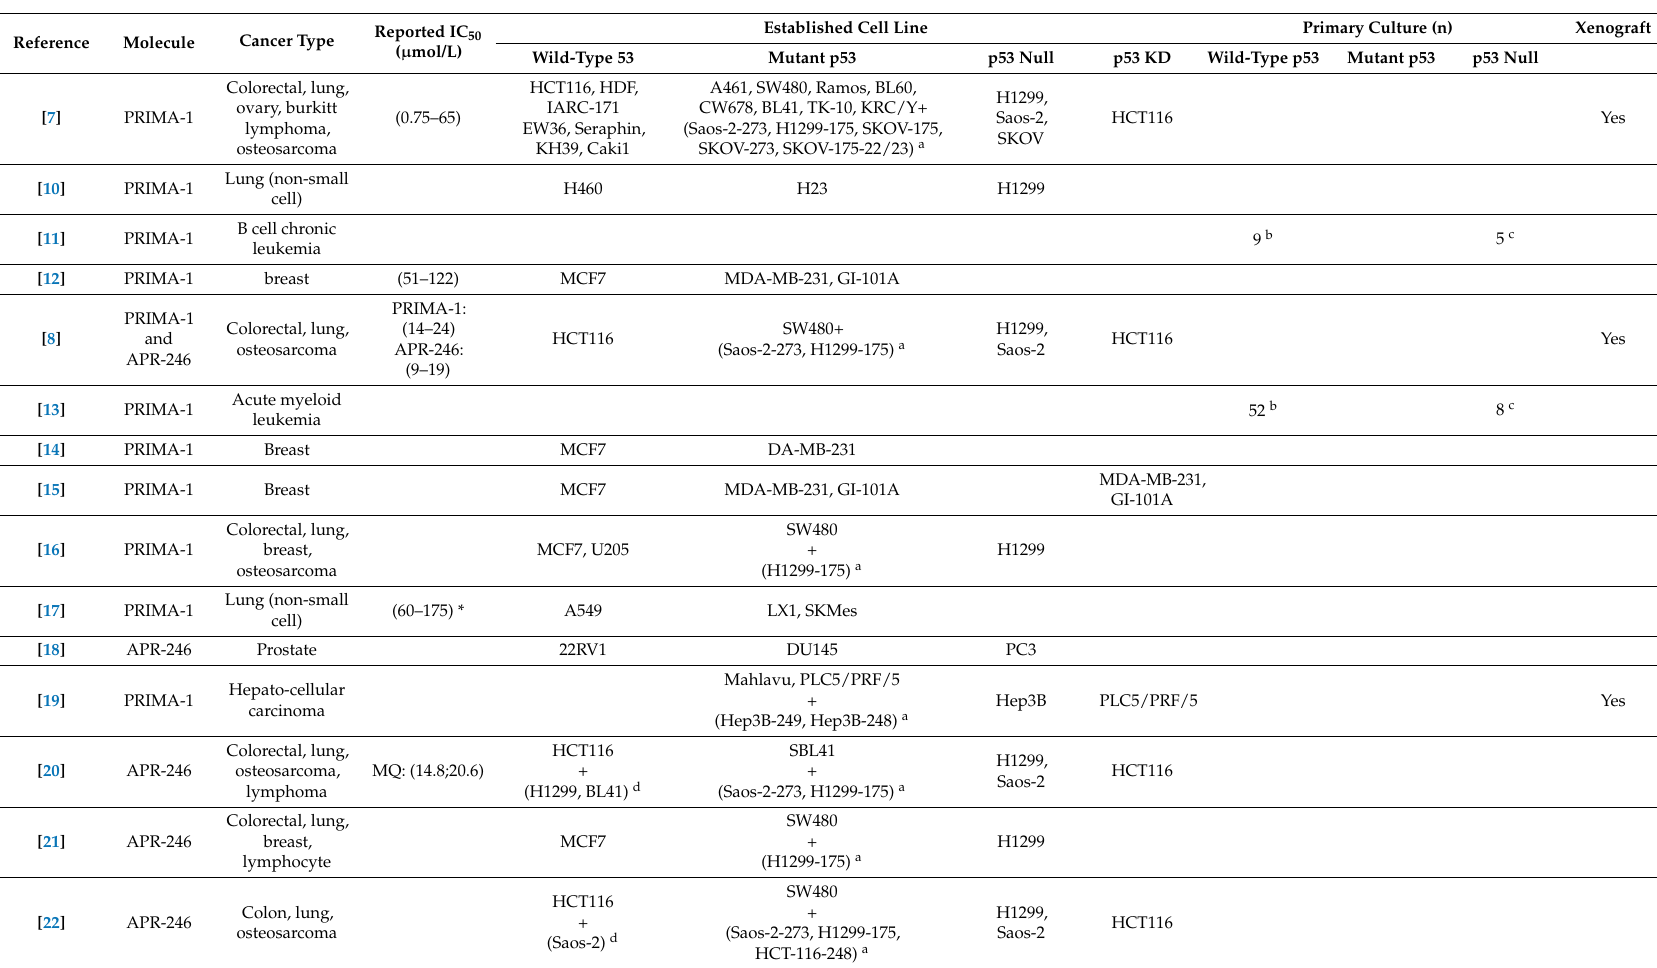
Table 1. Published studies since 2002 in Pubmed, reporting an anti-tumor effect (anti-proliferative and/or apoptotic effect) of PRIMA-1 or APR-246 in malignant disease, using established human cell lines, primary cultures or